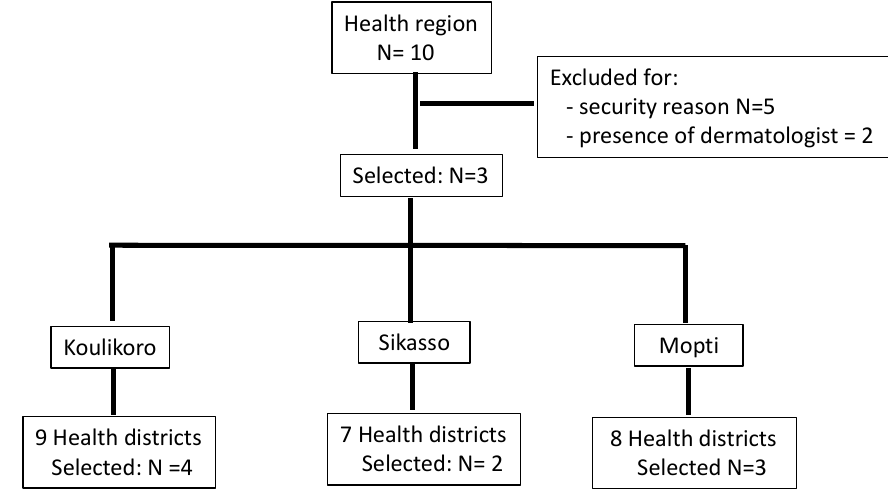
Figure 1. Flow chart of the selection of study sites: health region and districts.